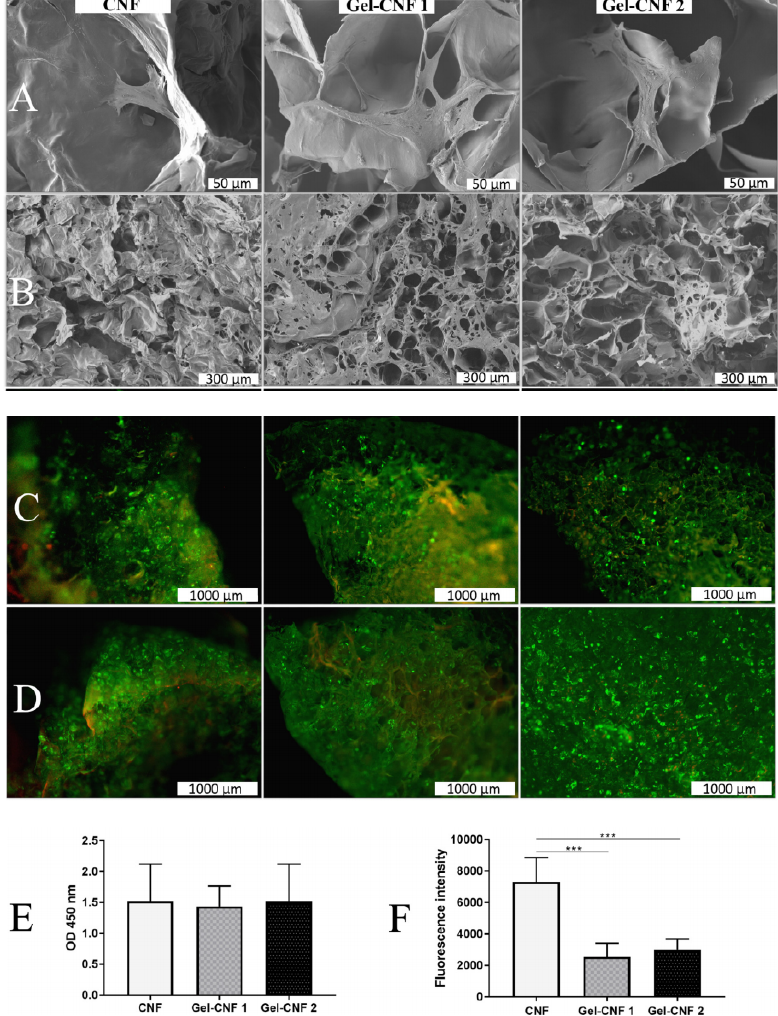
Figure 5. Cell–scaffold interactions in terms of cell attachment, morphology and viability. Attachment of hBMSCs by SEM after 1 ( A ) and 7 days ( B ). Live/dead assay after 1 ( C ) and 7 days ( D ). Live cells are stained green,anddeadcellsarestainedred. ( E )Cytotoxicityassessmentbylactatedehydrogenase(LDH)assayafter 1 day. ( F ) PicoGreen assay quantifying cell attachment after 1 day. ( p < 0.001) (Reprinted with